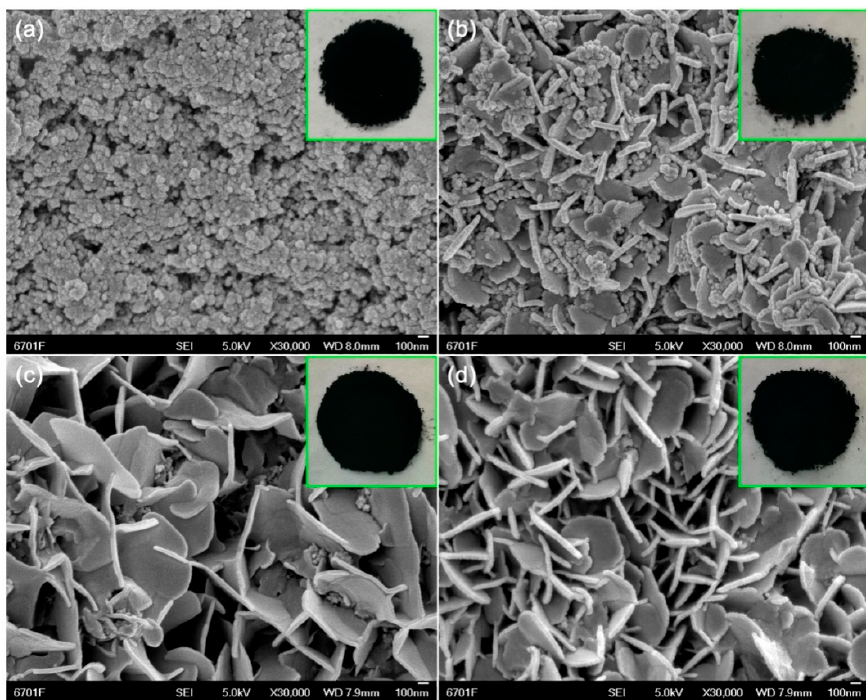
Figure 1. Scanning electron microscopy (SEM) images of CuS samples synthesized at 20 °C with different reaction times. ( a ) 0.5 h-20 °C, ( b ) 2 h-20 °C, ( c ) 10 h-20 °C, ( d ) 12 h-20 °C.